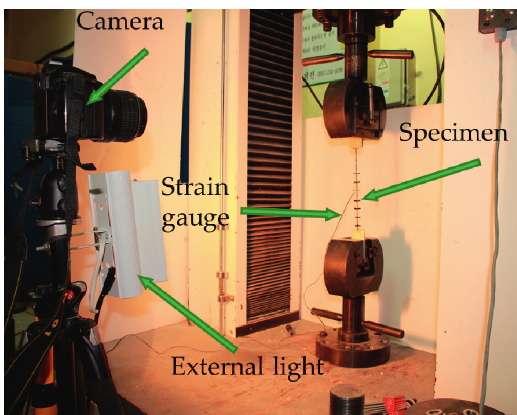
Figure 1: Experimental setup of direct tensile test of BFRP Table 1: Properties of FRP grids.